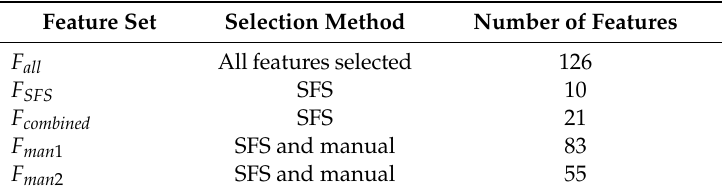
Table 5. Feature Selection